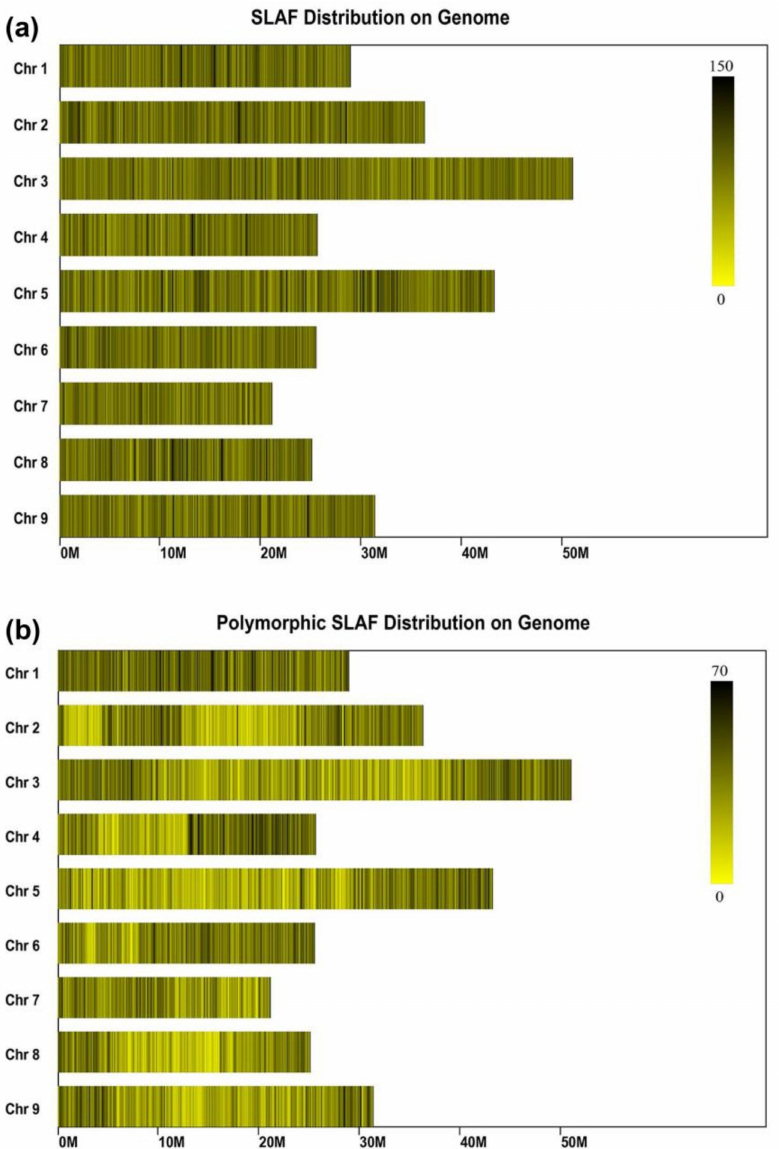
Figure 4. SLAF sequencing and genotyping. ( a ) The distribution of all obtained the SLAF tags on nine citrus chromosomes. ( b ) The distribution of all the polymorphic SLAF tags on nine citrus chromosomes. The x-axis represents the location on chromosomes, the y-axis represents the nine chromosomes, the x-axis represents the length of chromosome. When the color is darker, the SLAF tag number is